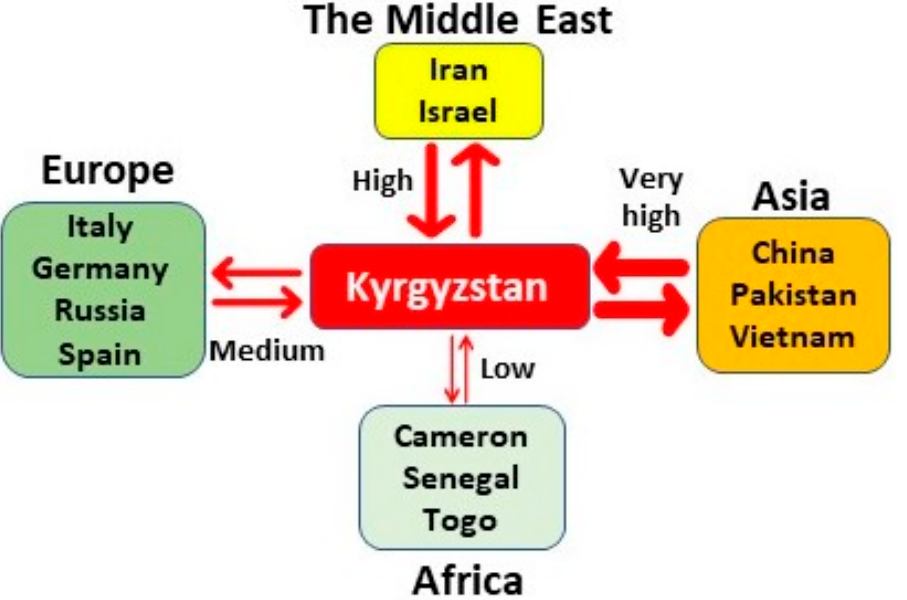
Figure 6. Cartoon linking Kyrgyzstan and the worldwide countries involved in the natural recombi- nation events of HDV. The size of arrows indicates the recombination rate of Kyrgyzstan strains after 2014 associated with geographically distinct areas. The colours Orange, Yellow, Green, and Light Green correspond to very high, high, medium, and low detected recombination rates, respec- tively.